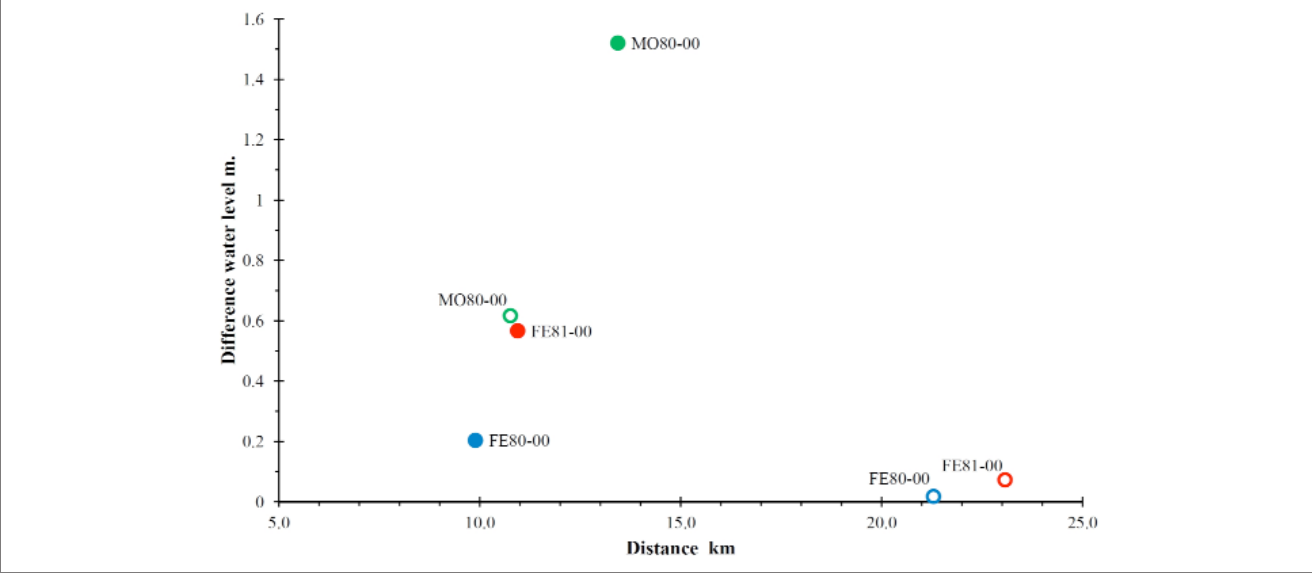
Figure 3. Differences in the water levels at the three monitoring stations, as related to the distance in concomitance with the two relevant seismic events characterized by M 5.9 (full dot) and M 5.8 (empty